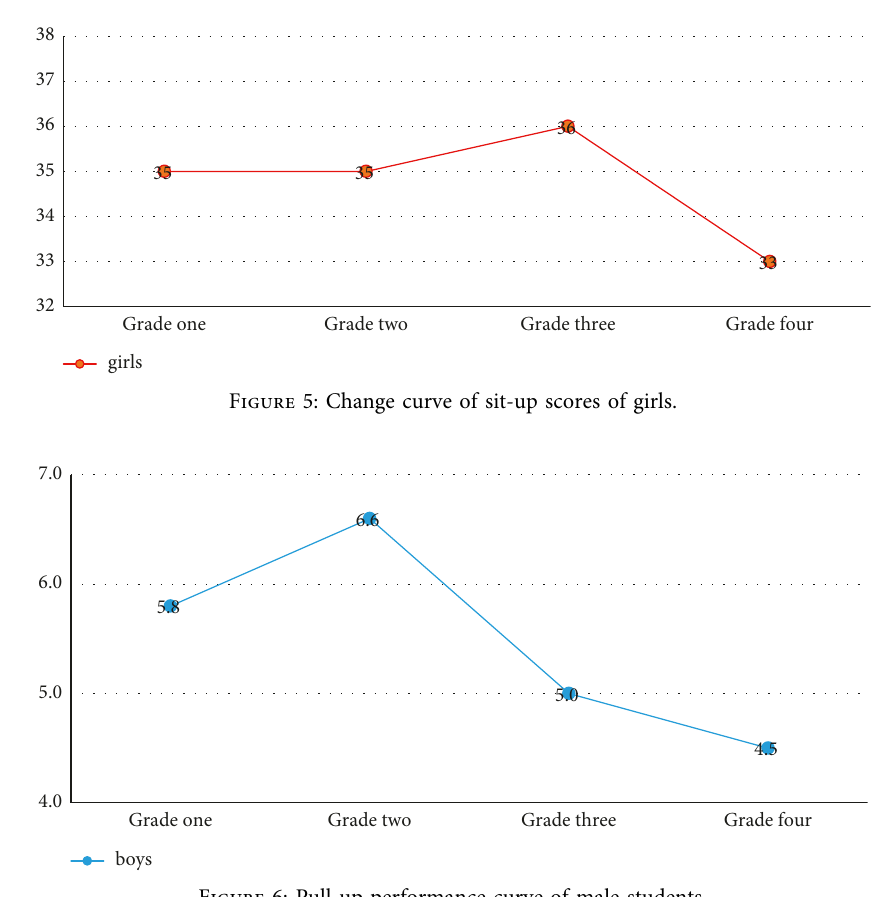
Figure 6: Pull-up performance curve of male